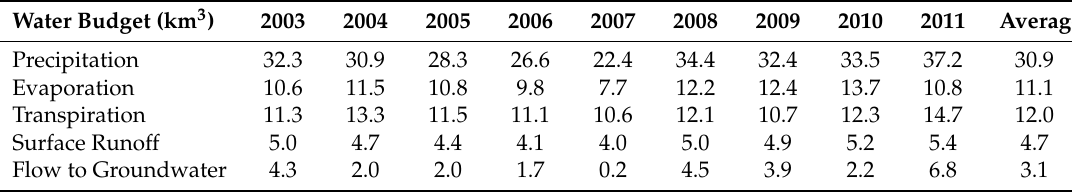
Table 4. Precipitation data and estimated annual water budget components of the Sakarya River Basin.